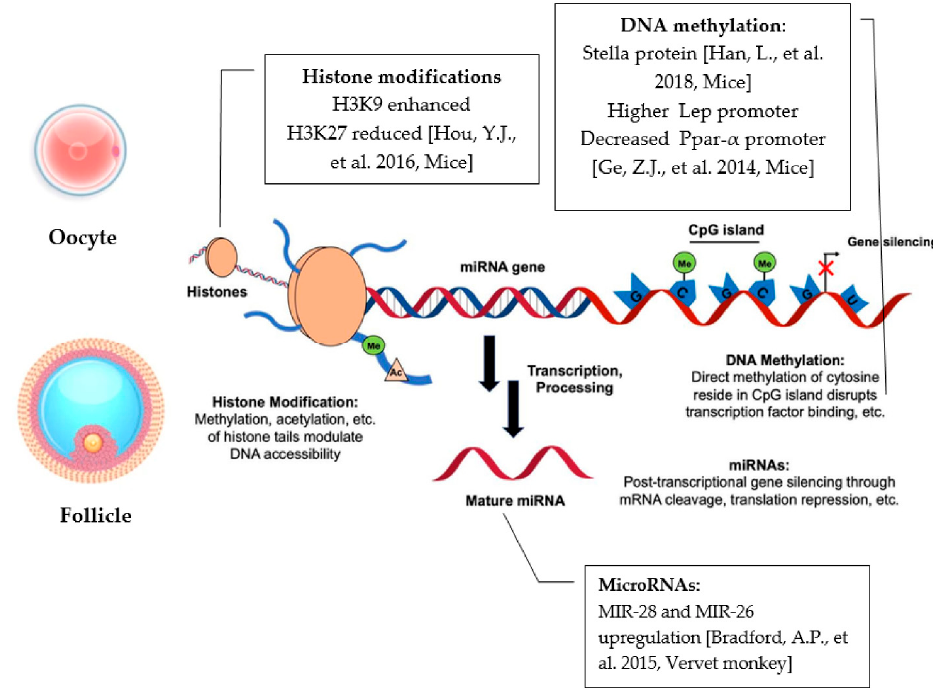
Figure 2. Summary figure of the main findings related to the impacts of high ‐ fat diet on oocyte and follicular epigenetic mechanisms, DNA methylation, miRNAs and histone modifications [36,57,58,60].